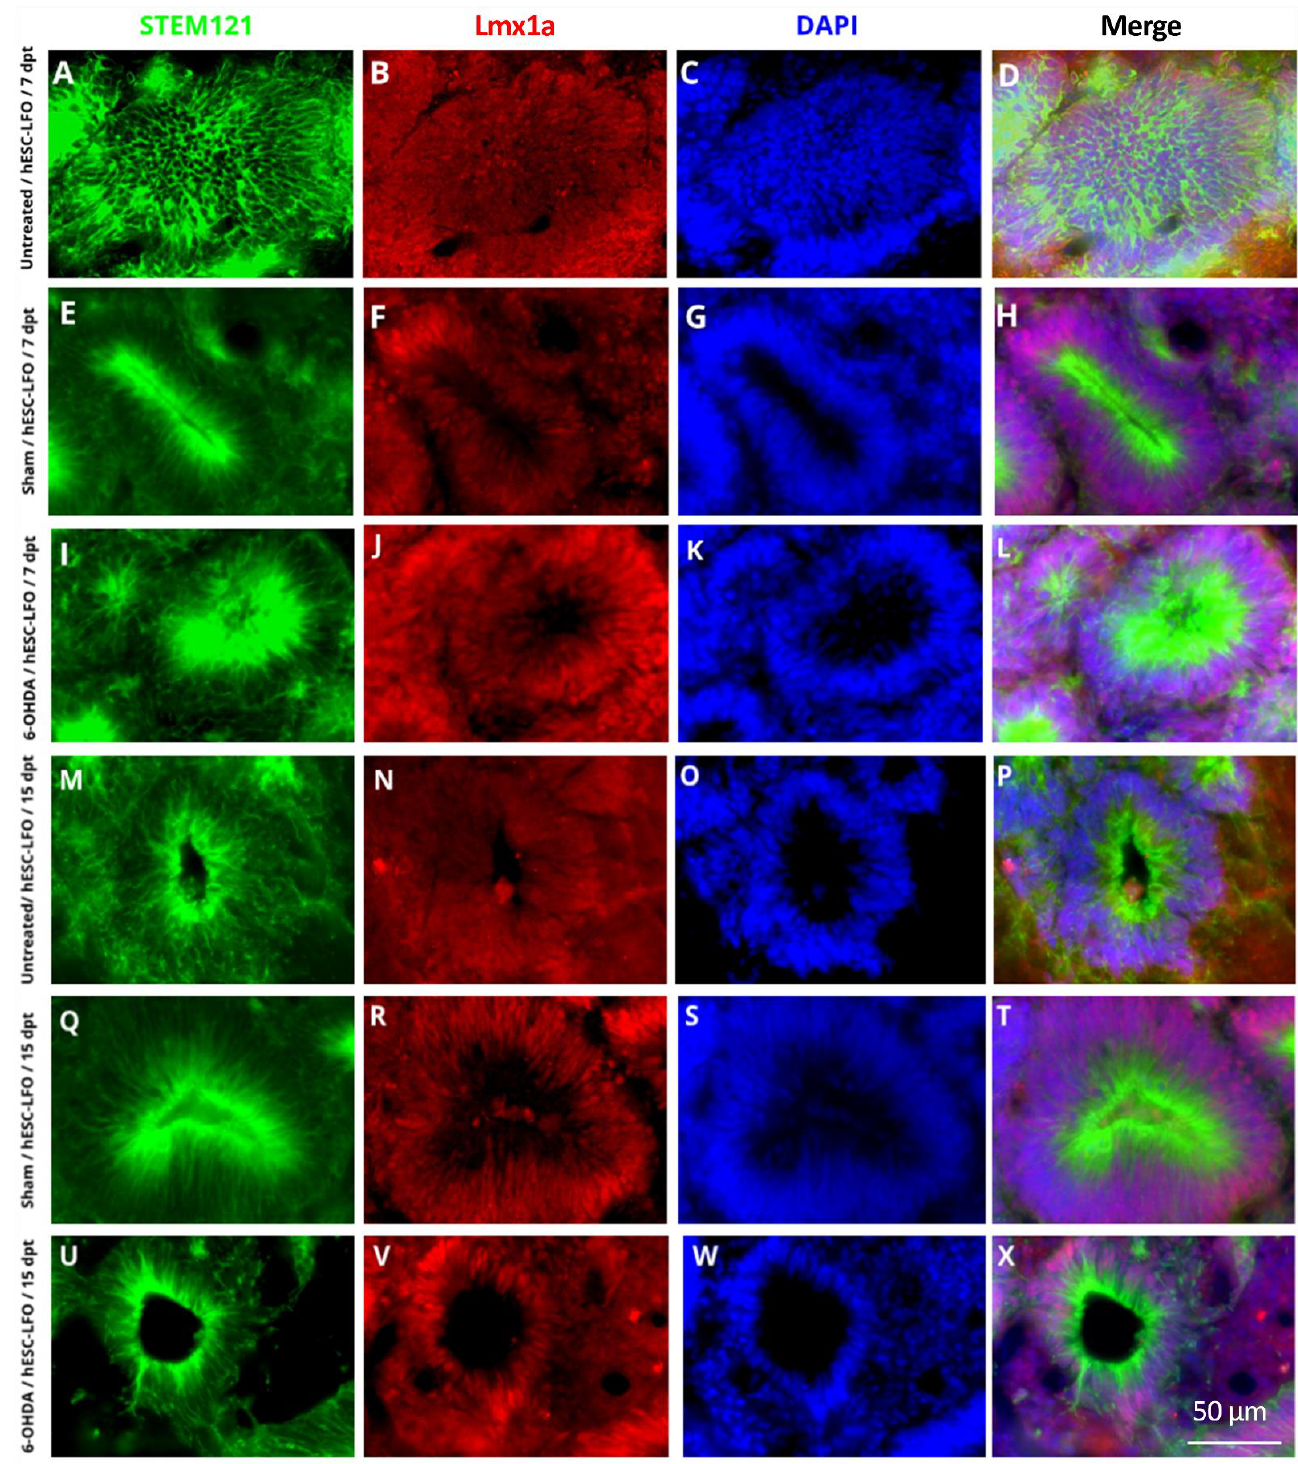
Figure 2. Neural rosettes of grafted hESC-LFO EBCs expressed Lmx1a at 7- and 15-days post- transplantation in the substantia nigra . Representative photomicrographs of neural rosettes from hESC-LFO EBCs grafts expressing Lmx1a. Neural rosettes cytoplasm was marked with the human cell antibody STEM121 (green). Lmx1a signal (red) was present in the nuclei of cells conforming the neural rosettes. DAPI was used to stain cell nuclei (blue). Transplanted tissue corresponds to ( A – D , M – P ) untreated, ( E – H , Q – T ) sham, and ( I – L , U – X ) 6-OHDA at ( A – L ) 7 and ( M – X ) 15 dpt. Lmx1a: LIM homeobox transcription factor 1 alpha; dpt: days post-transplantation.